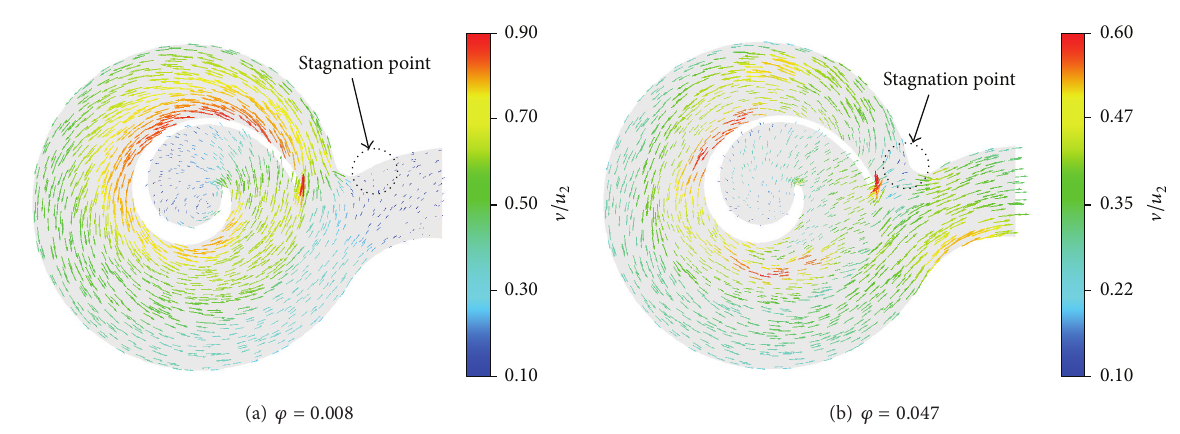
Figure 14: Absolute velocity vectors ( 𝛽 𝑏2 = 24 , 𝜃 0 = 0 ∘